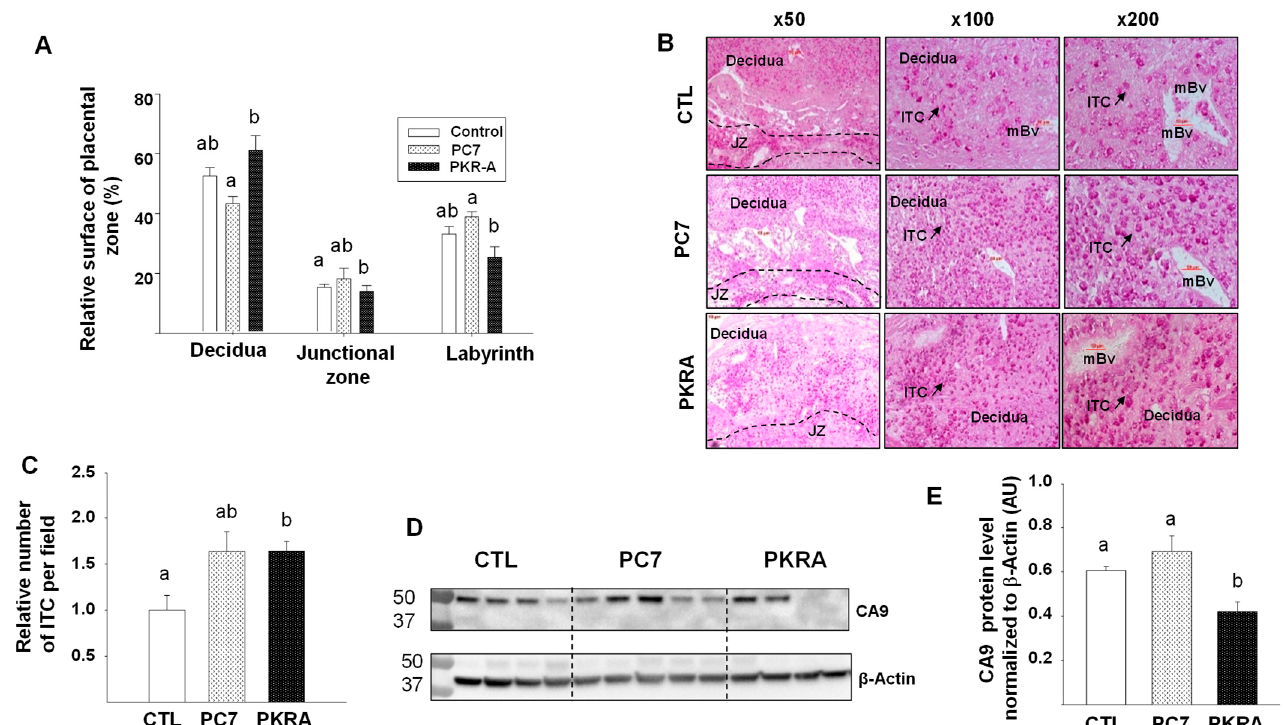
Figure 4. Effects of prokineticin antagonists’ on placental structure and trophoblasts invasion. ( A ) depicts analysis of the placental zones of CTL, PC7 and PKRA placentas. For each group, at least three placental sections/animal were analyzed. The graph shows proportions of the surface layer of 3 zones of the placenta (labyrinth, junctional zone, and decidua). Surfaces of the 3 layers were measured on parasagittal sections for each placenta. Mean values were used to calculate the mean (SEM) surface proportion of the layers. p < 0.05. NS, not significant. ( B ) shows representative photomicrographs of placental sections stained with Peroxide Acid Shiff at different magnifications. Placentas were collected from CTL, PC7 and PKRA treated mice at 12.5 dpc. JZ: Junctional Zone; ITC: Invasive Trophoblast Cell; mBv: Maternal Blood Vessel. ( C ) depicts a graph that compares the number glycogenic cells in the maternal decidua. ( D , E ) shows western blot analysis and quantification of CA9 protein levels in the placenta collected from CTL, PC7 and PKRA treated mice. Standardization of immunoreactivity was performed using antibodies against β -actin. Data are represented as mean ± SEM. p < 0.05. Bars with different letters are significantly different from each other.